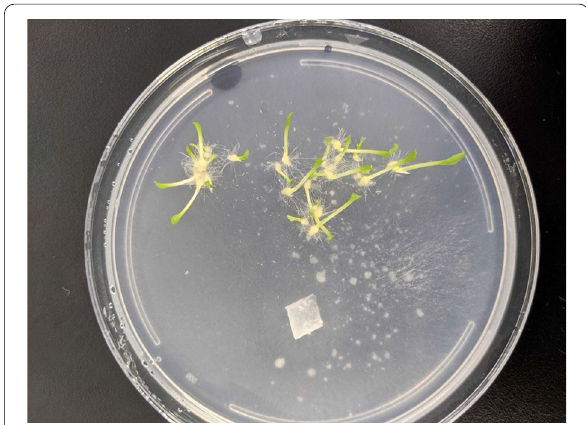
Fig. 2 Leaf-bearing (Stage 5) Spiranthes cernua seedlings on the surface of oatmeal agar (OMA) co-cultured with Tulasnella calospora 266. The photo was taken 42 days after sowing and incubation in darkness at ambient temperature followed by 7 days under a white light photoperiod